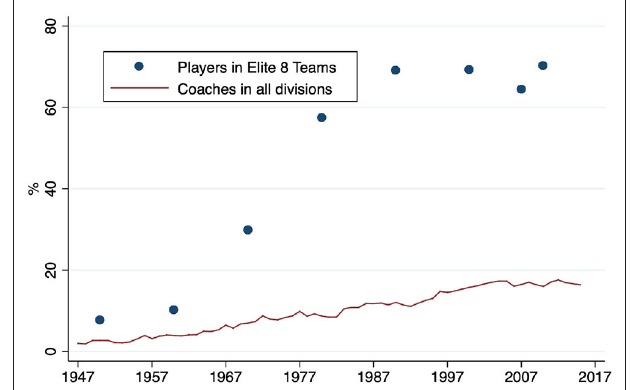
FIGURE 1 | Share of Black players and